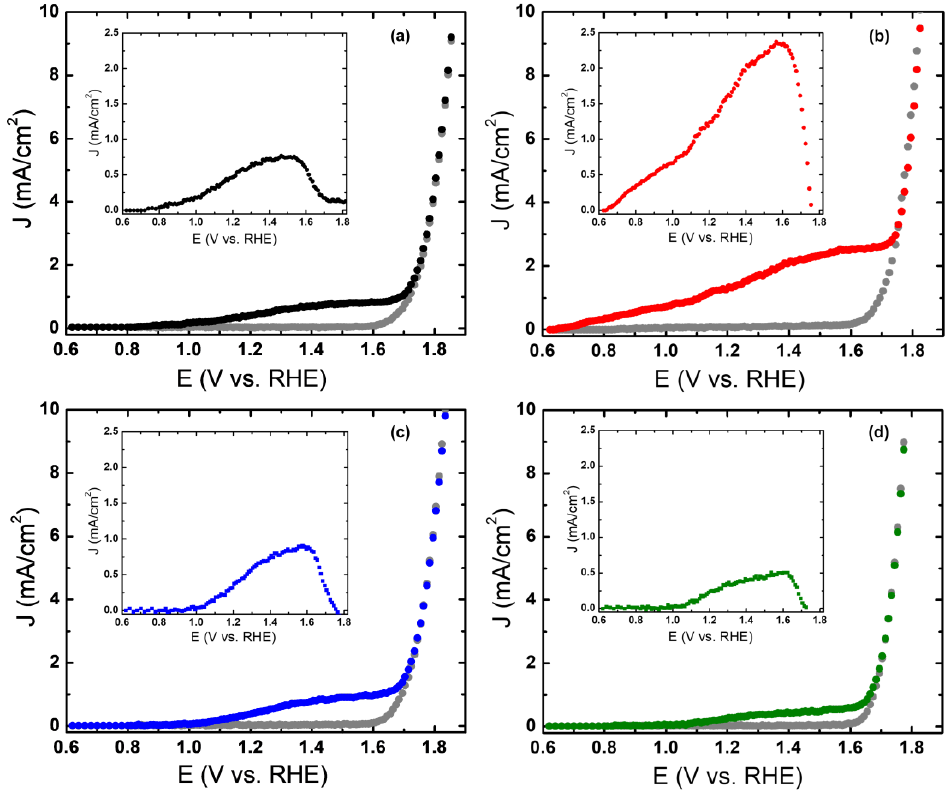
Figure 8. ( a – d ) are the current density-potential (j- E) characteristics of α -Fe 2 O 3 /FTO electrodes in 1 M NaOH in dark and under illumination for samples prepared at 10, 14, 18, and 22 cm, respectively. (Inset) The photocurrent-potential curve of α -Fe 2 O 3 /FTO electrode in 1 M NaOH. Table 2. Values of Thickness, Effective Absorption (A E ), and Photocurrent Efficiency.